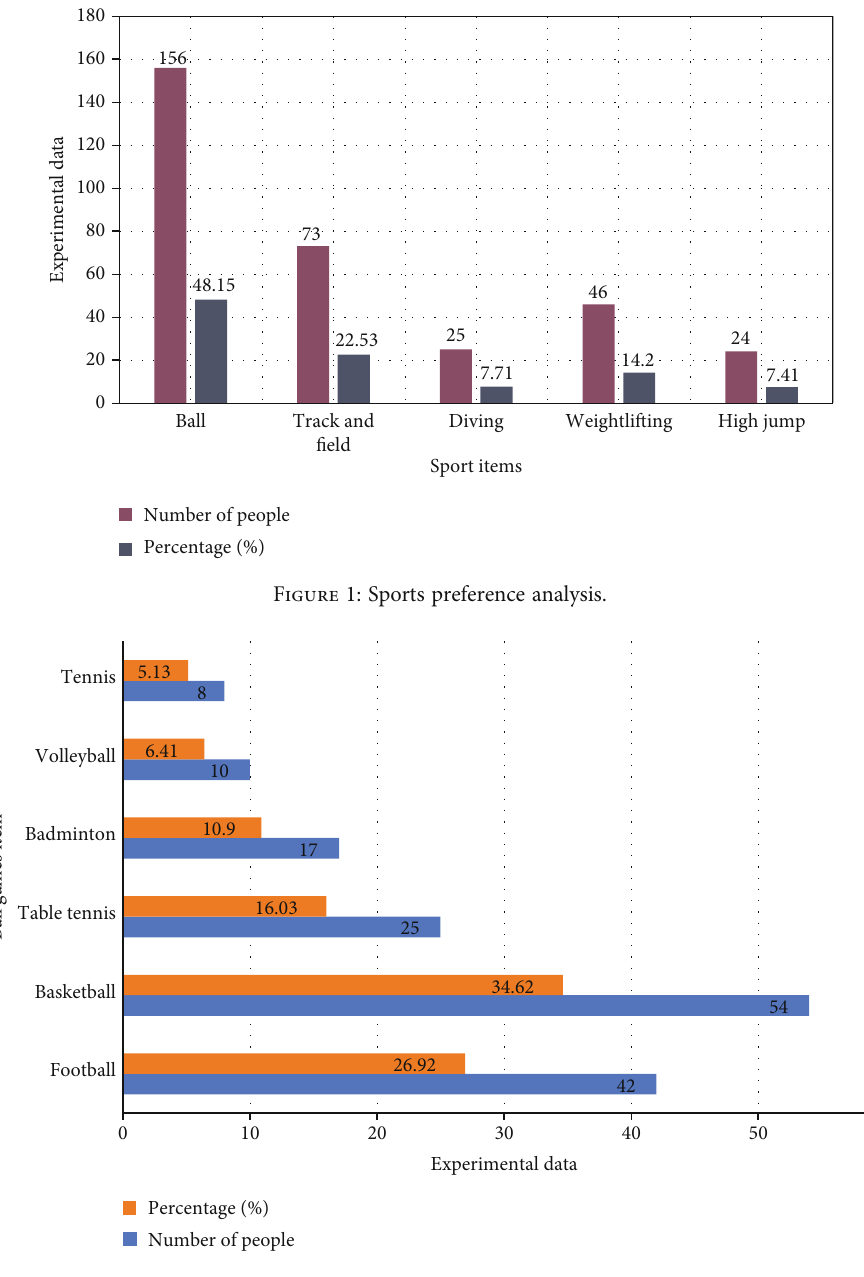
Figure 2: Comparative analysis of ball game preferences. Table 2: Analysis of support rate of folk-custom sports